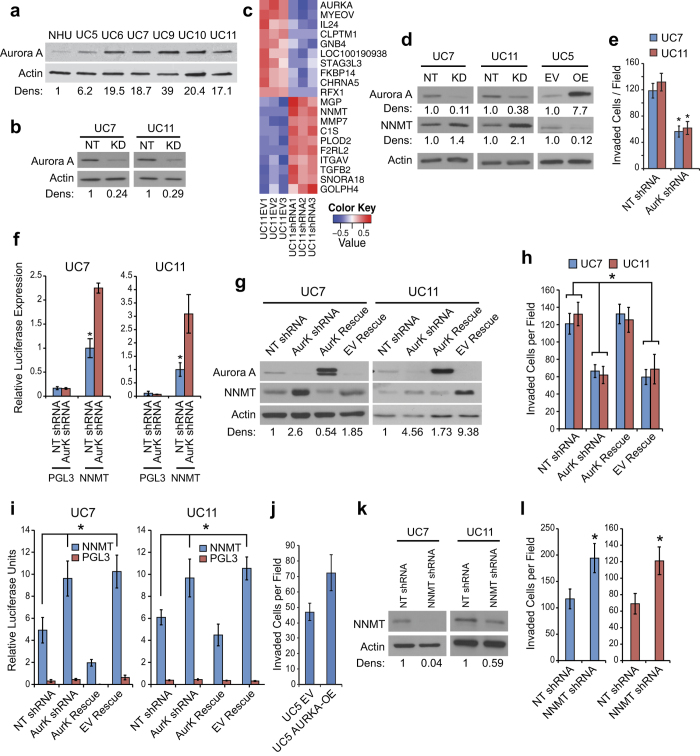
Effects of AURKA A on NNMT expression and cell invasion.(a) Panel of bladder cancer cells shows different levels of AURKA expression in UC5, UC6, UC7, UC 9, UC10 and UC11 cell lines. Note low level of AURKA expression in cultured normal urothelial (NHU) cells. Full length blots are shown in Supplementary Fig. S6. (b) Using a lentiviral shRNA construct AURKA was silenced by ~75% in UC7 and UC11 cells. Full length blots are shown in Supplementary Fig. S6. (c) Heatmap of most significantly up- and down-regulated genes after silencing of AURKA in UC11 cell line. (d) AURKA was silenced using a lentiviral vector. Upon silencing, NNMT is upregulated by 3–4 fold in UC7 and UC11 cell lines. In contrast, overexpression of AURKA in UC5 cells resulted with downregulation of NNMT. Full length blots are shown in Supplementary Fig. S6. (e) Upon silencing of AURKA cell invasion is decreased by ~3 fold in both UC7 and UC11 cells in a matrigel invasion assay (*P < 0.01). (f) A luciferase promoter analysis of NNMT reveals that NNMT’s upregulation is transcriptionally regulated in both cell lines upon silencing of AURKA (*P < 0.05). (g) AURKA KO UC7 and UC11 cells were treated with AURKA rescue vectors and western blot was performed to verify the rescue of AURKA and NNMT expression. Full length blots are shown in Supplementary Fig. S6. (h) Quantitation of cell invasion through matrigel coated invasion chambers in AURKA silenced and rescued UC7 and UC11 cell lines (*P < 0.05). (i) Luciferase based promoter analysis of the NNMT promoter indicated that when AURKA is rescued, luciferase expression is returned to lower than normal levels in both UC7 and UC11cell lines (*P < 0.05). (j) Overexpression of AURKA in UC5 cells which resulted in downregulation of NNMT (see Fig. 1d) increased cell invasion in matrigel coated chambers. (k) NNMT was silenced 80–90% in UC7 and UC11 cell lines using lentiviral shRNA directed against NNMT. A reduction of NNMT expression was observed by western blot. Full length blots are shown in Supplementary Fig. S6. (l) An increase in cell invasion was observed in both cell lines in NNMT shRNA treated cells when compared to NT shRNA (*P < 0.05).